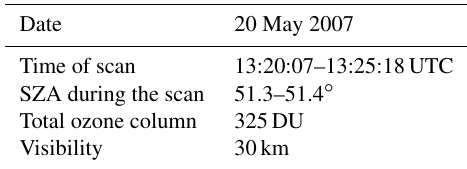
Figure 3. Schematic presentation on the data flow of Brewer UV ir- radiance data from the Level 0 raw counts to Level 1 and Level 2 ir- radiance data. 1 Meinander at al. (2003); 2 Eq. (1); 3 Eq. (2); 4 Eq. (3); 5 Eq. (4); 6 Eq. (5); 7 Lakkala et al. (2008); 8 Slaper et al. (1995). Table 1. Information on the case UV scan of Jokioinen Brewer no. 107 selected for graphical demonstration on the phases in the data